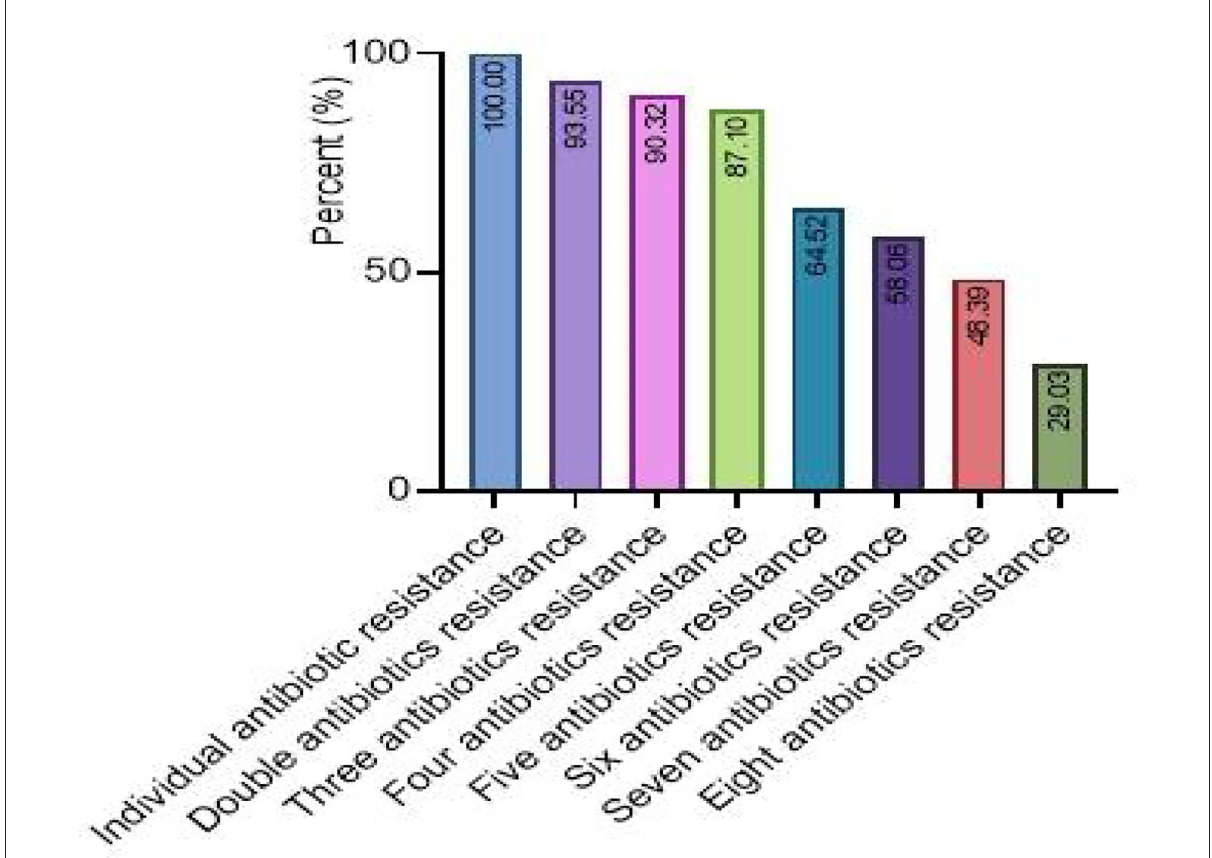
FIGURE4 The multi-drug resistance analysis of S. aureus